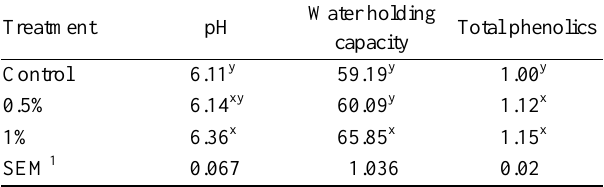
Table 1. pH, water holding capacity (%), and total phenolic contents (mg gallic acid equivalent/g meat) of the thigh meat from the broilers fed the combination of gallic and linoleic acid Water Treatment pH